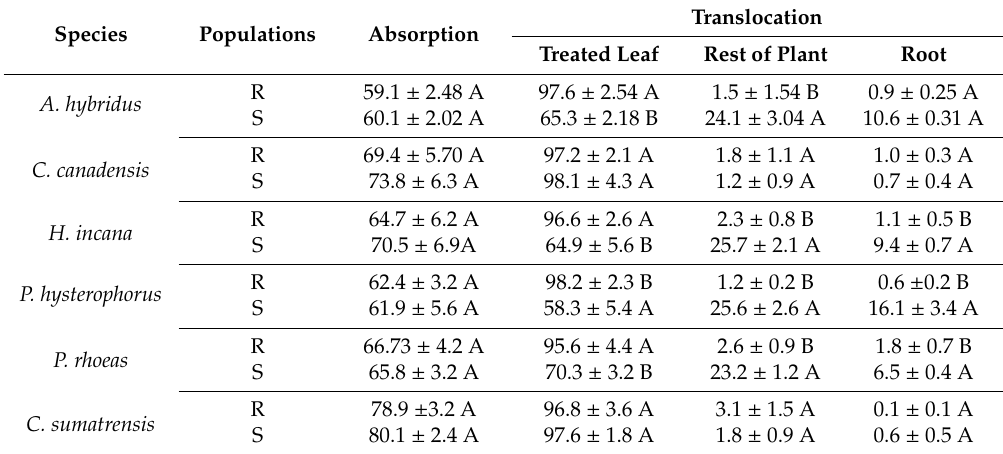
Table 3. 14 C-2,4-D absorption (% of from total applied) and translocation (% from uptake) in di ff erent dicotyledonous weeds R and S populations at 96 h after treatment (HAT).